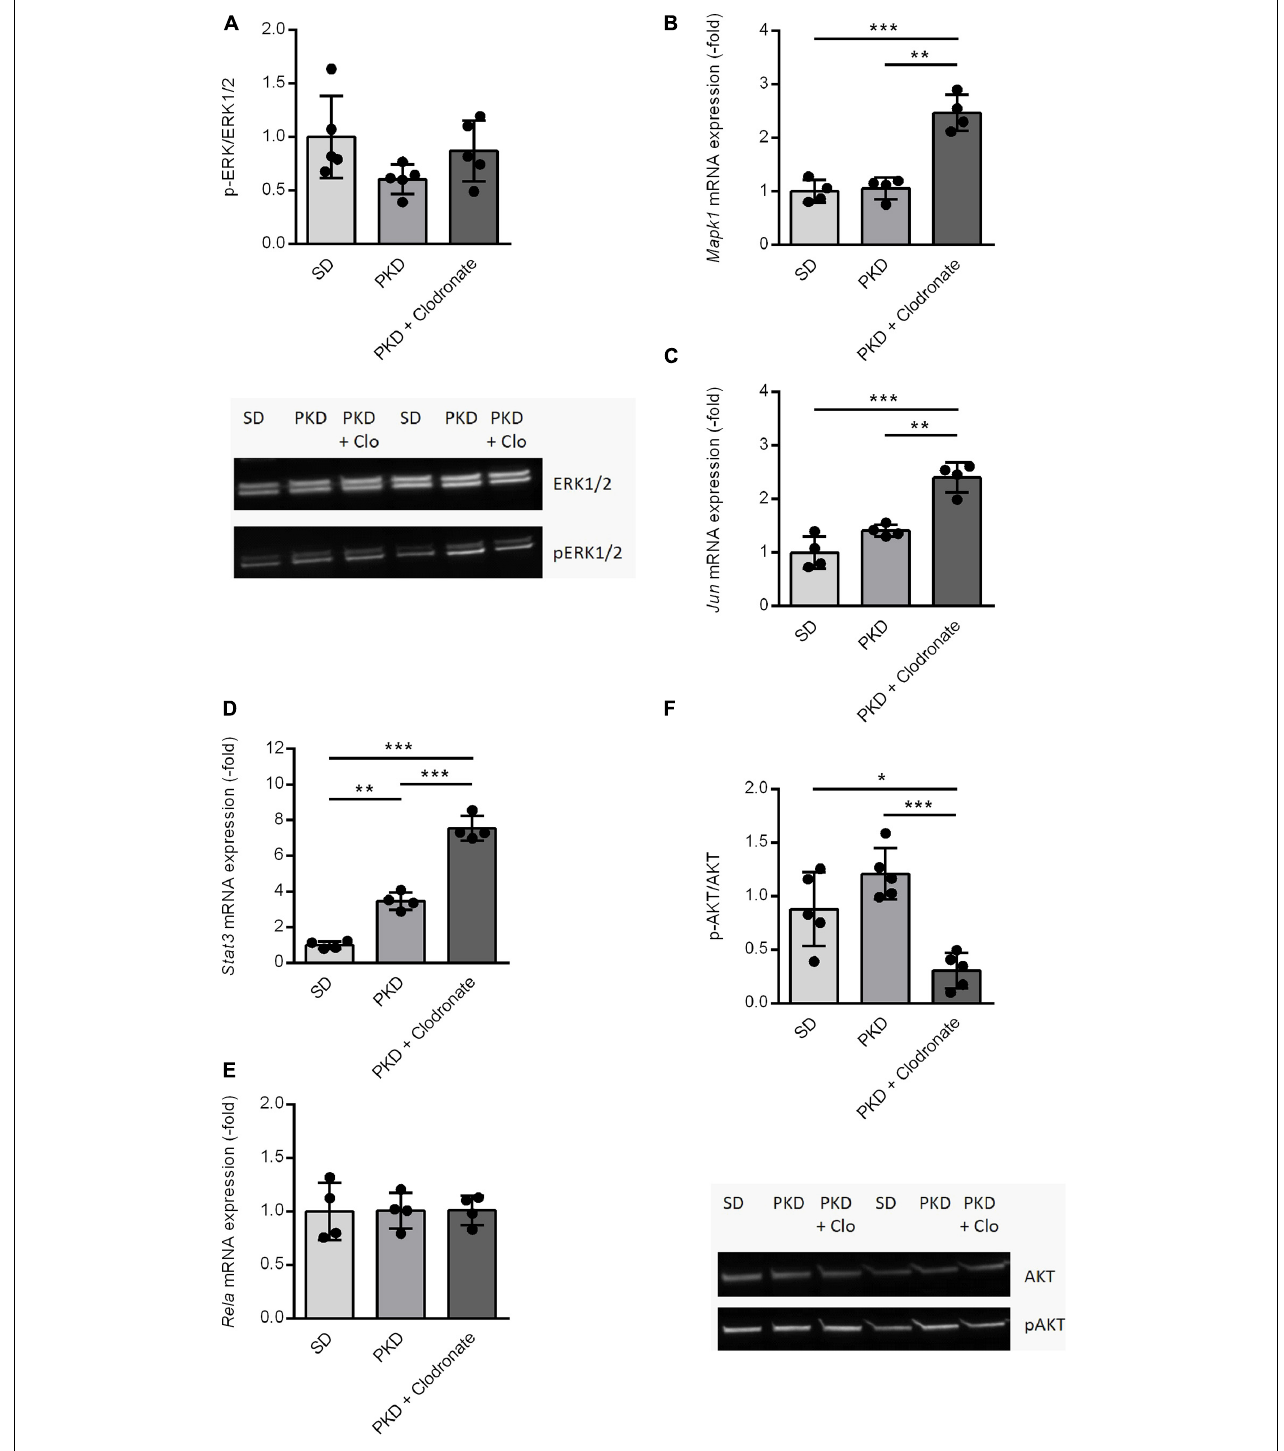
FIGURE 4 | Expression and activation changes of Fgf2-related factors and pathways. (A) The activation of the MAPK/ERK1/2 pathway showed no significant differences between SD, PKD, and PKD+ clodronate rats as assessed by western blots for ERK1/2 and phosphorylated (p)ERK1/2. (B–E) Clodronate treatment led to an induction of Mapk1 (B) and Jun (C) expressions and increased the expression of Stat3 (D) compared to PKD rats, whereas the mRNA expression of Rela (E) showed no differences between the three groups. (F) The activity of the PI3K/AKT signaling pathway was significantly reduced in clodronate-treated PKD rats compared to both SD and PKD rats, indicated by the decreased phosphorylated (p)AKT/AKT ratios in the western blot analysis. * p < 0.05, ** p < 0.01, *** p < 0.001. PKD + Clo = PKD + Clodronate.